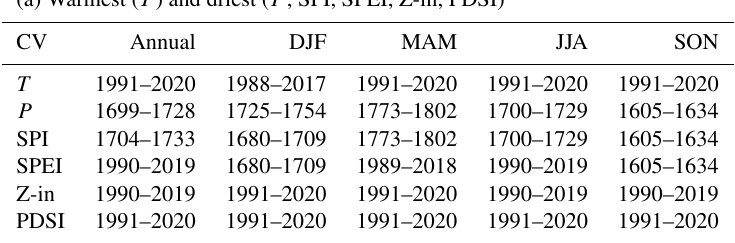
Table 1. The warmest and driest (a) and the coldest and wettest (b) 30-year periods in annual and seasonal series of climate variables (CVs) in the Czech Lands in 1501–2020CE: T – temperature, P – precipitation, SPI, SPEI, Z-in (Z index), and PDSI – drought indices.